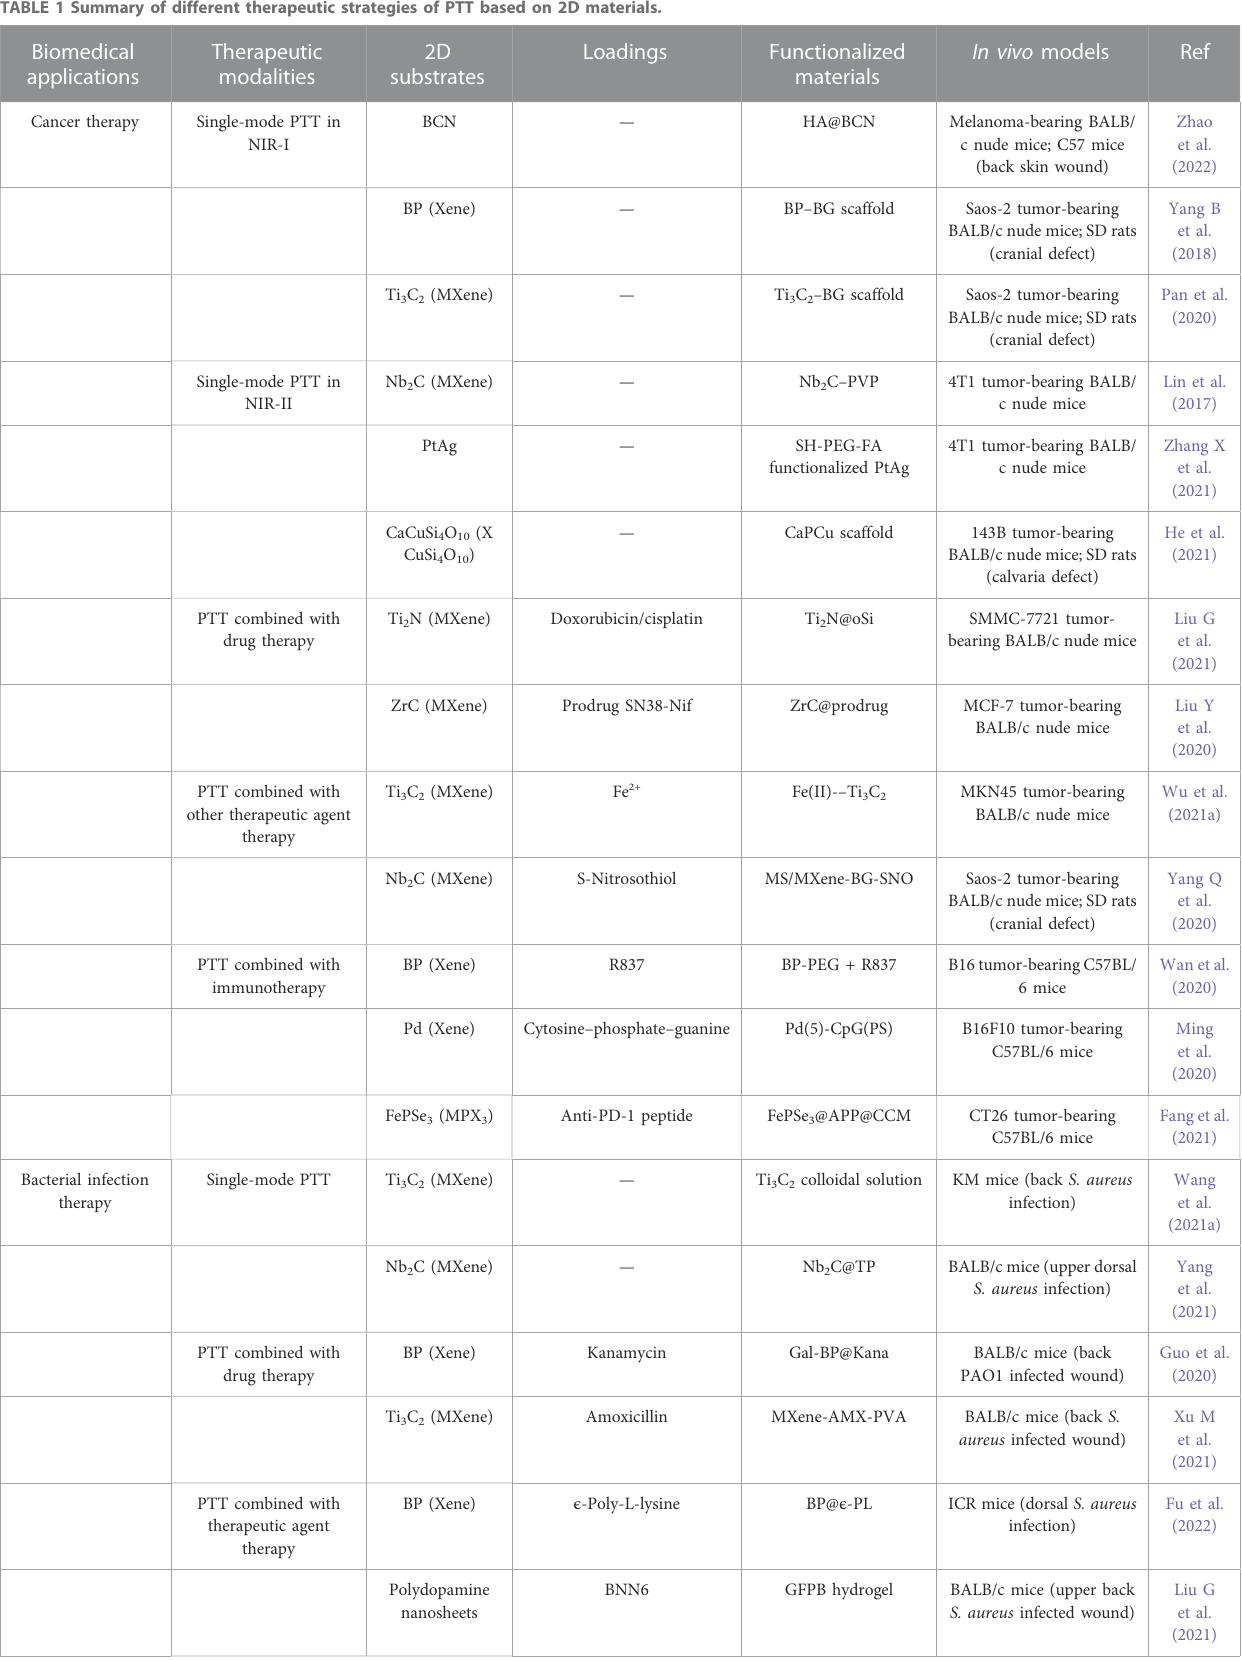
TABLE 1 Summary of different therapeutic strategies of PTT based on 2D